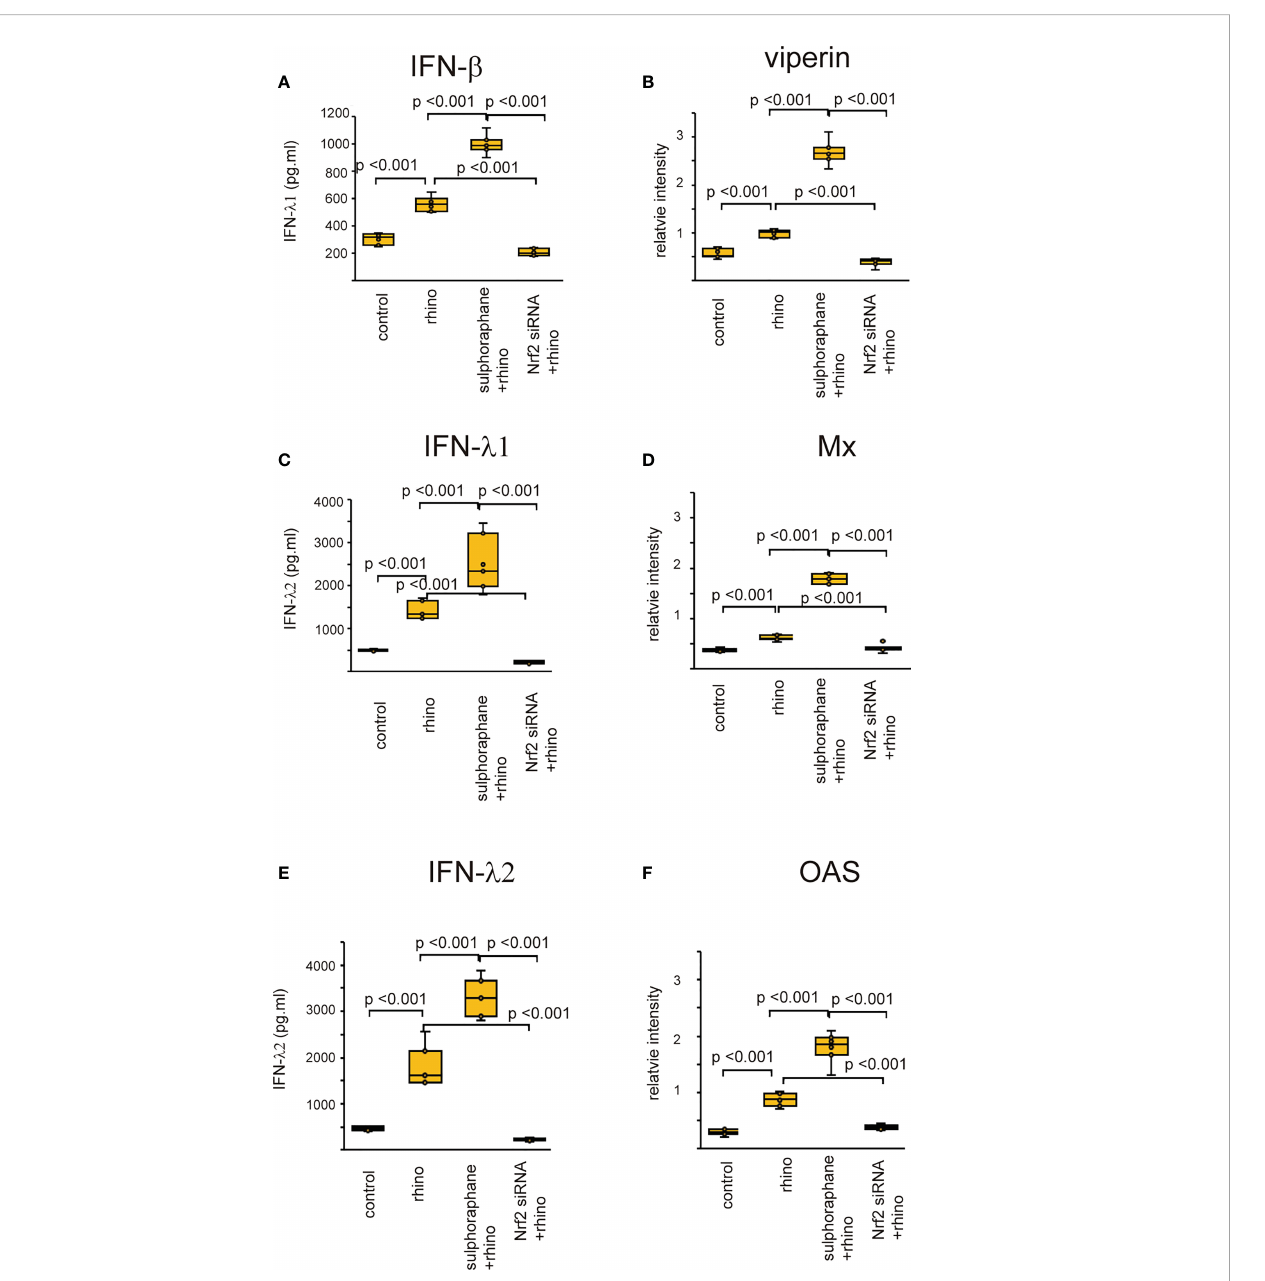
FIGURE 7 The concentration of IFN- b (A) , IFN- l 1 (C) , and IFN- l 2 (E) in basal media of cultured cells and the expression levels of viperin (B) Mx (D) and OAS (F) in cultured cells transfected with Nrf2 siRNA and pretreated with sulforaphane and then, followed by RV 16 infection which were evaluated with ELISA (A, C, E) and western blot (B, D, F) . Data are mean ± SEM from 7 different epithelial donors. Control indicates non-treated normal epithelial cells. Rhino indicates epithelial cells infected with RV 16. Sulforaphane + rhino indicates the epithelial cells pretreated with sulforaphane at 5 uM followed by RV 16 infection. Nrf2siRNA + rhino indicates the cells transfected with Nrf2 siRNA were infected with RV